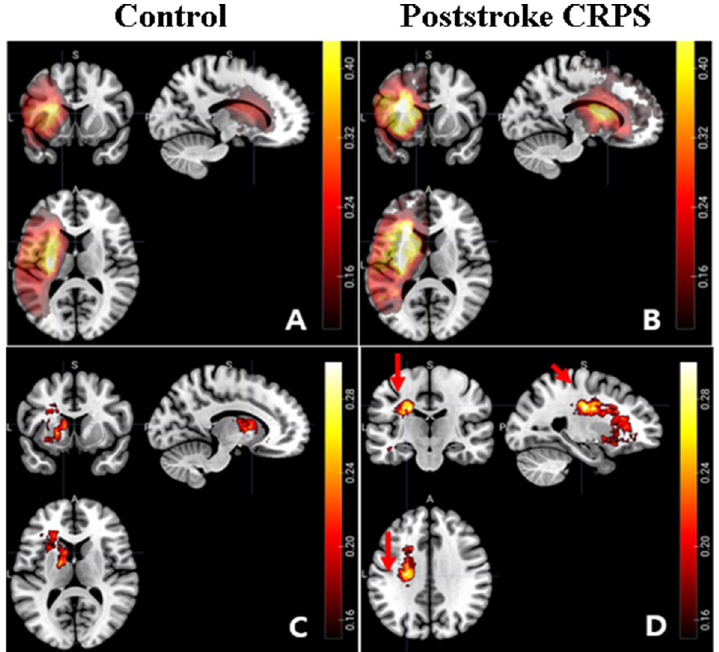
Figure 3. Lesion-overlaid maps of controls and CRPS patients. The colour bar represents the percentage of overlapping lesions (range: 0 [no overlap] to 1 [complete overlap]) ( A : control group, B : poststroke CRPS group) or the subtracted percentage of overlapped lesions (the difference in the percentage of overlapped lesions) from patients in the control and poststroke CRPS groups ( C : control group, D : poststroke CRPS group). The red arrows indicate the central sulcus ( D ). MR images are displayed according to neurological convention. Consequently the head of the caudate nucleus, putamen, and white matter complexes in the corona radiata were more frequently involved in the poststroke CRPS group than in the control group.